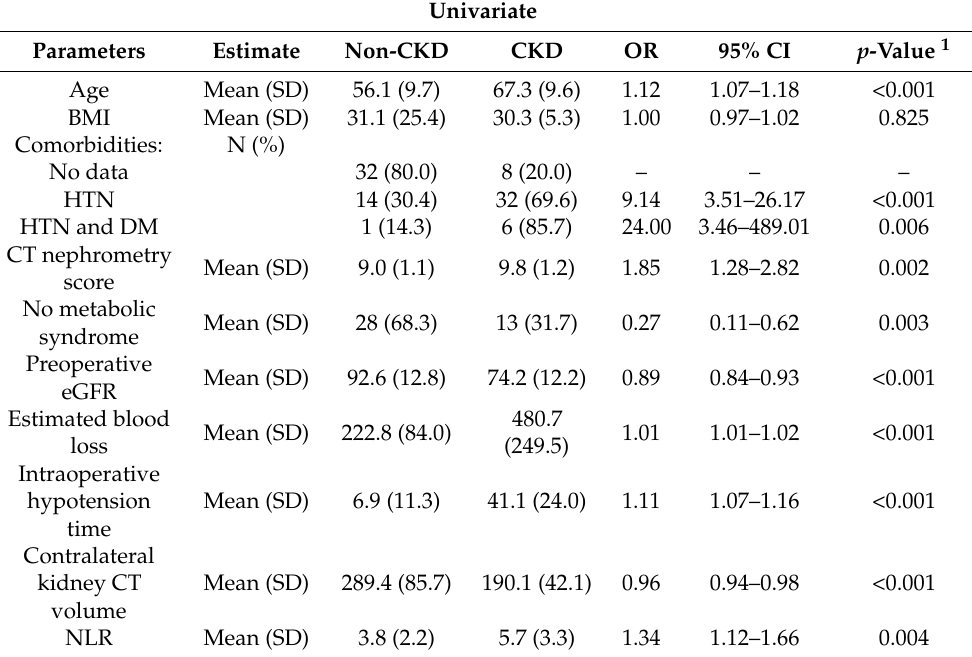
Table 2. Clinical characteristics of CKD potential predictors in the univariate analysis.